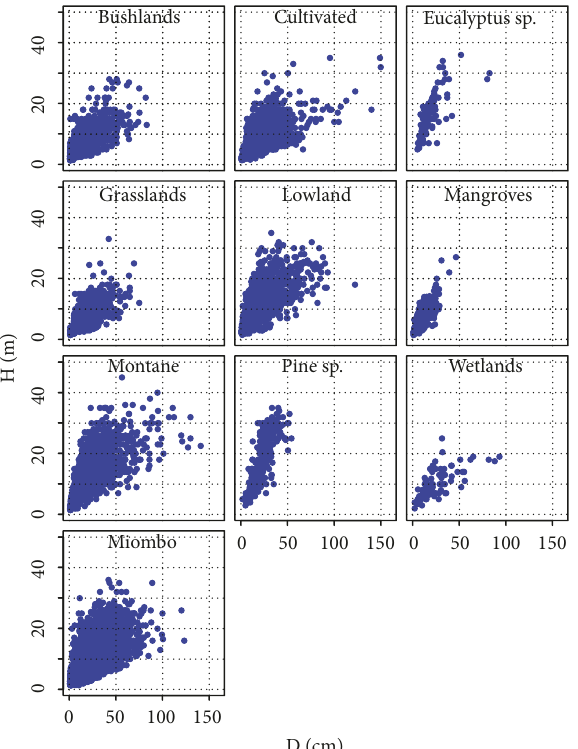
Figure 3: Scatter plots of H-D